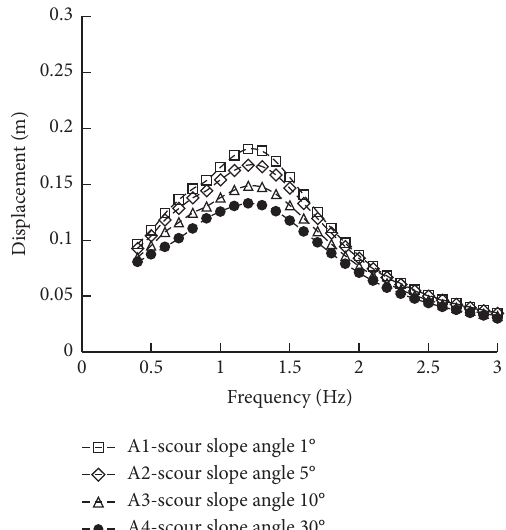
Figure 11: Dynamic response of caisson foundation under dif- ferent scour slope angles. Figure 9: Dynamic response of caisson foundation under different